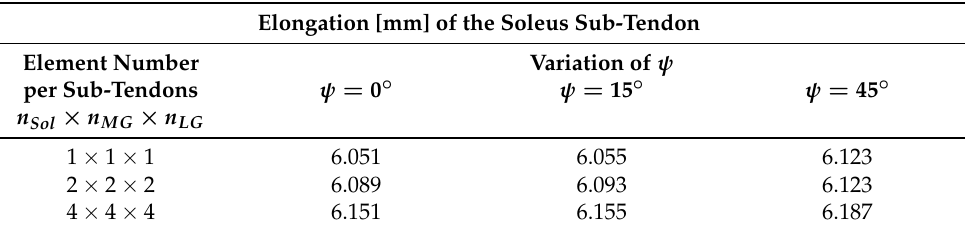
Table 2. Elongation results in [mm] for several mesh refinements for the straight and pretwisted soleus sub-tendon of Type III from the neo-Hookean material model under N = 400 N tensile force. Elongation [mm] of the Soleus Sub-Tendon Element Number Variation of ψ per Sub-Tendons ψ = 0 ◦ ψ = 15 ◦ ψ = 45 ◦ n Sol × n MG × n LG